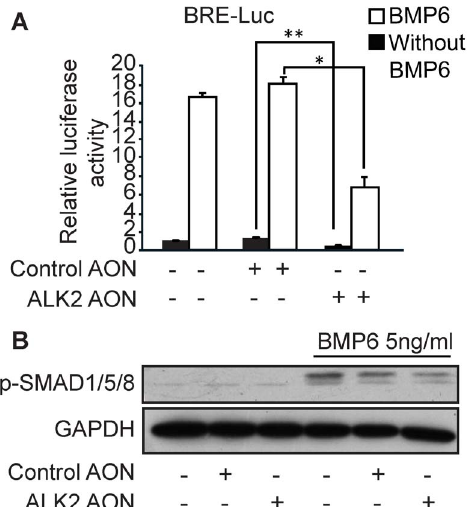
Figure 4. ALK2 AON-induced exon skipping decreased BMP signaling in 2H11 endothelial cells. (A) 2H11 cells were cotrans- fected with 100 nM of the indicated AON and the BMP reporter construct BRE-Luc for 16 hours. Subsequently, cells were starved for 8 hours, and then stimulated with 50 ng/ml BMP6 overnight. Luciferase reporter activity was measured after stimulation and normalized with b - gal activity. (B) 2H11 cells were transfected with 100 nM control AON or 100 nM ALK2 AON in proliferation medium. One day after transfection, the cells were serum starved for overnight and stimulated with 5 ng/ml BMP6 for 1 hour. Protein was isolated and western blotting was performed to check the Smad1/5/8 phosphorylation. GAPDH was used as loading control. Data are means 6 SD from three independent experiments. Statistical analysis was performed using Student’s t-test, using the untransfected samples as reference. *P , 0.05, **P ,